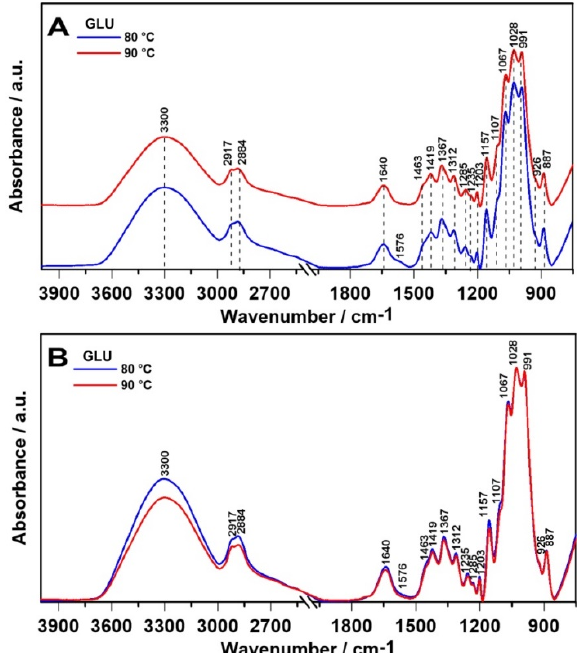
Figure 2. The relative intensity of ATR FT-IR (attenuated total reflection Fourier transform infrared spectroscopy) spectra of 1,3- β - d -glucan ( A ) and spectra normalized to the highest intensity band (1028 cm − 1 ) arising from C-O vibration ( B ).